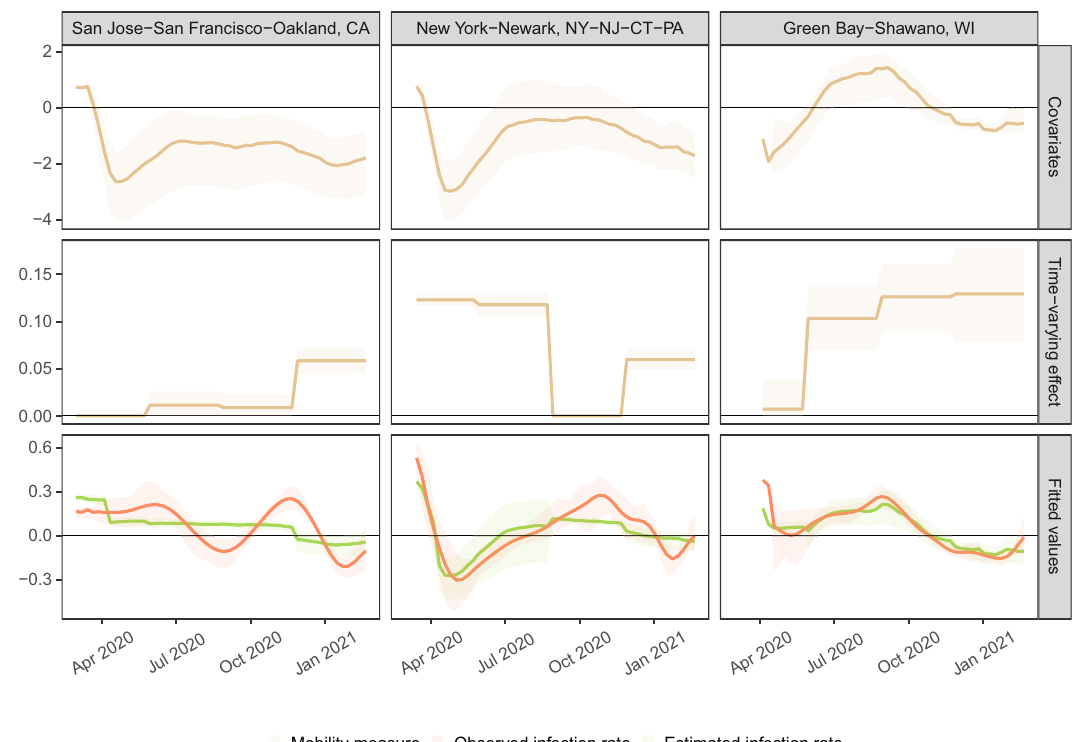
Fig. 4 Illustrative model data, estimated effects, and fi tted values. Mobility covariates (top), estimated time-varying effect of mobility (middle), and fi tted and observed infection growth rate values (bottom) for three examples CSAs. New York has a strong estimated effect of mobility in waves one and two, whereas Green Bay has a strong estimated effect of mobility in the second to fourth waves. San Jose has a moderate effect of mobility in the fourth wave. Median (solid lines) and 95% quantiles (shaded) are